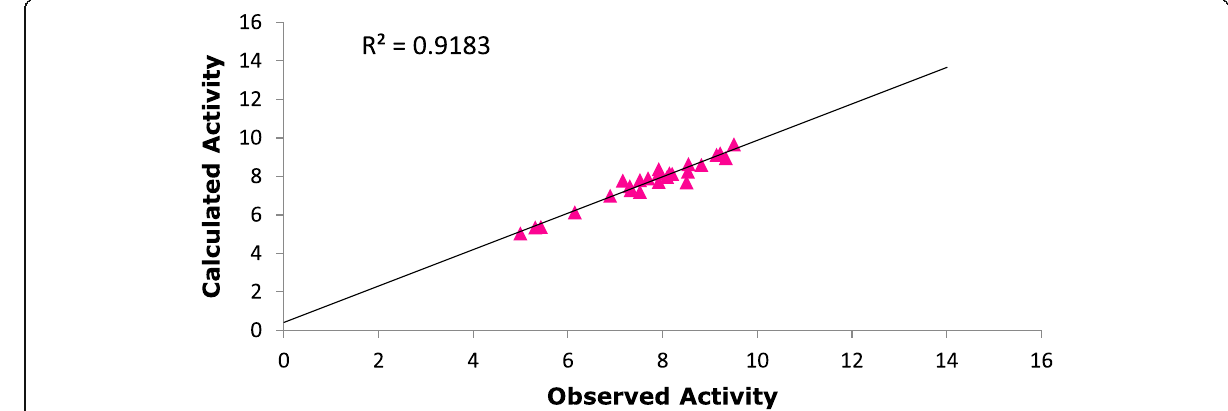
Fig. 1 Plot of predicted activity against observed activity of training set